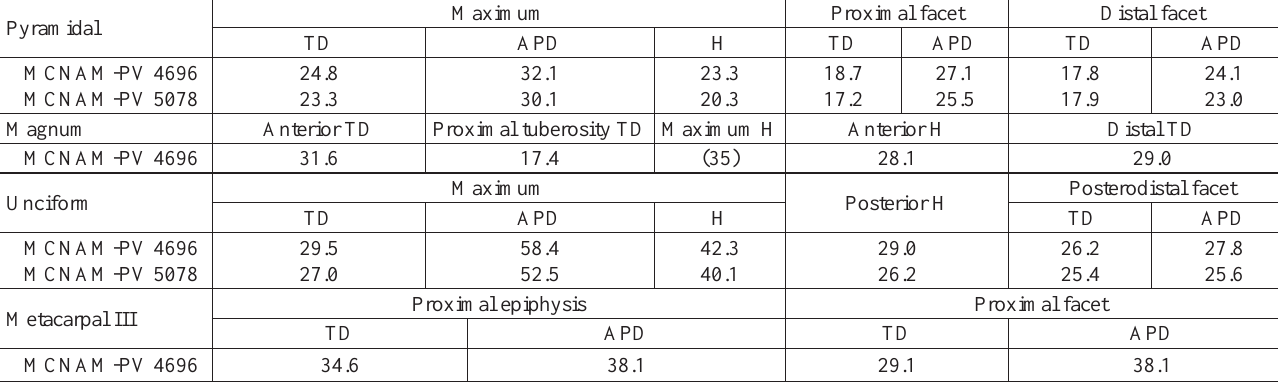
Table 3. Measurements (in mm) of the carpals and metacarpal of Gualta cuyana from Quebrada Fiera, Mendoza. Values in parentheses are ap- proximate. APD, anteroposterior diameter; H, height; TD, transversal